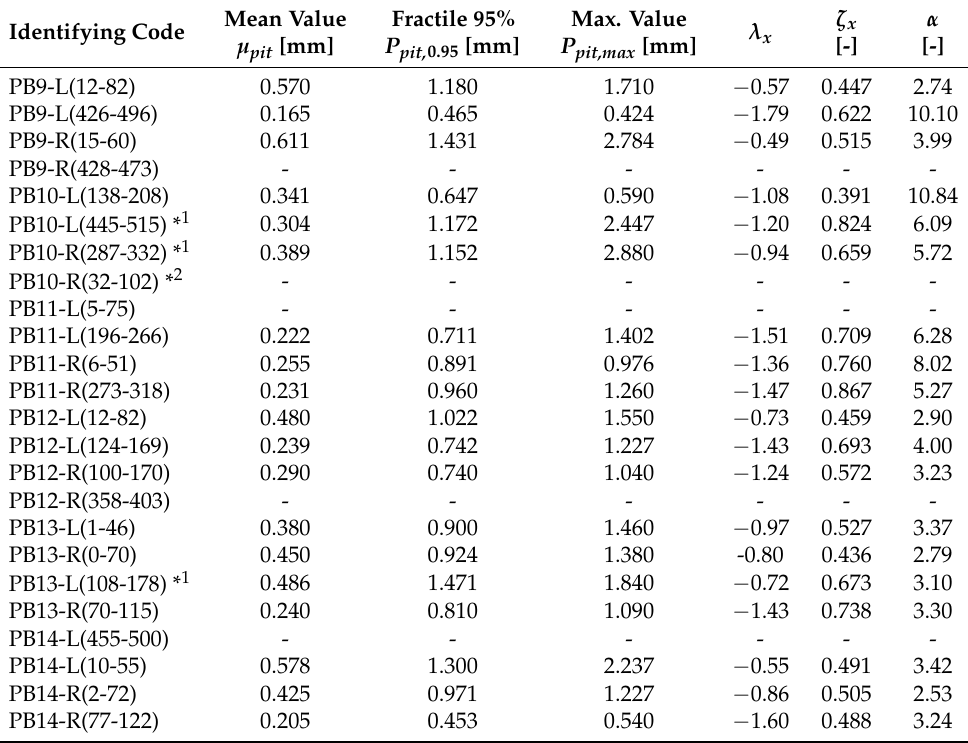
Table 2. Key features of lognormal distributions of corroded prestressing strands. Identifying